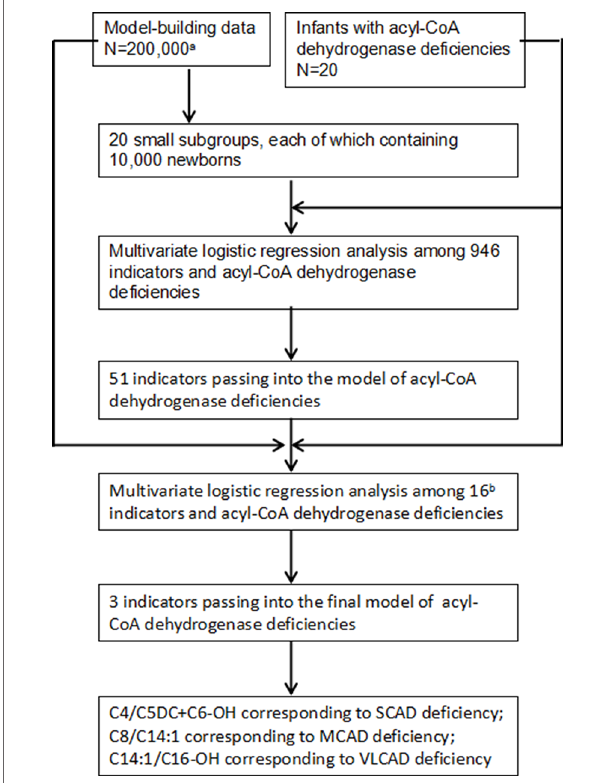
FIGURE 2 | Flowchart of optimal indicators selection. SCAD, short chain acyl-CoA dehydrogenase; MCAD, medium chain acyl-CoA dehydrogenase; VLCAD, very long chain acyl-CoA dehydrogenase. a Newborns screened by tandem mass spectrometry. b Indicators passing into multivariate logistic regression model in at least two small